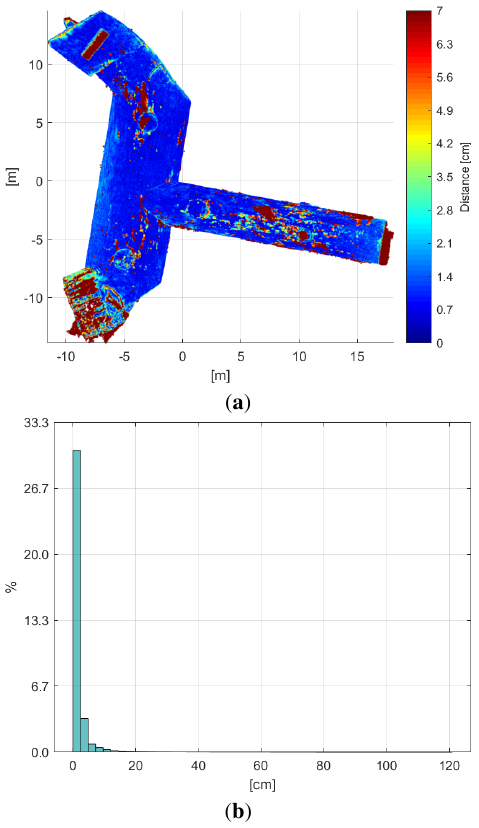
Figure 7. Photogrammetric 3D model (with optimal scale fac- tor) accuracy assessment: comparison with the TLS 3D model. Point clouds registered in local coordinates with the ICP algo- rithm. ( a ) Map of point-to-point distances. ( b ) Histogram of dis- tances shown in ( a ). Table 3. Reconstruction error in case study 1